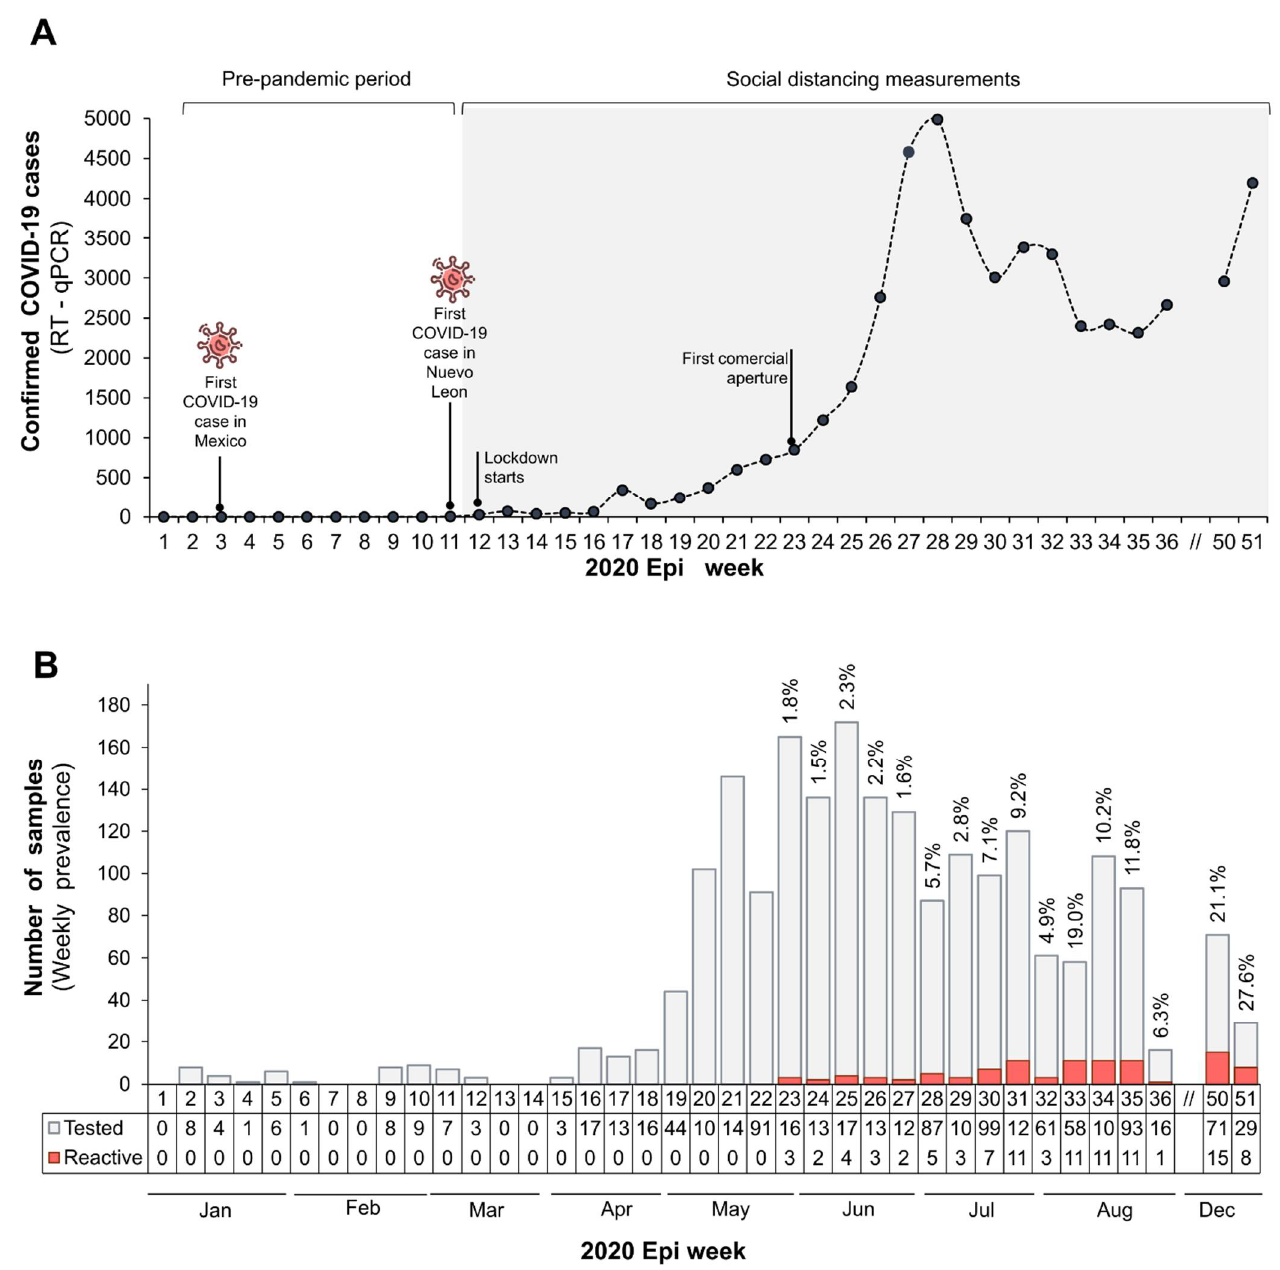
Figure 1. Dynamics of asymptomatic SARS-CoV-2 cases detected by anti-SARS-CoV-2 IgG analysis in blood donors during 2020 in Nuevo Leon, Mexico. ( A ) Curve of RT-qPCR-confirmed new COVID-19 cases per epi week recorded in Nuevo Leon. The gray shading indicates the pandemic period. Significant pandemic events for the Nuevo Leon area are indicated. ( B ) Prevalence of anti-SARS-CoV-2 IgG per epi week was estimated by dividing the number of positive cases (red bars) by the number of tested samples (gray bars) per week. S/C index ≥ 1.4 was considered as a positive result. The respective seroprevalence of SARS-CoV-2 IgG is shown on the top of each bar.